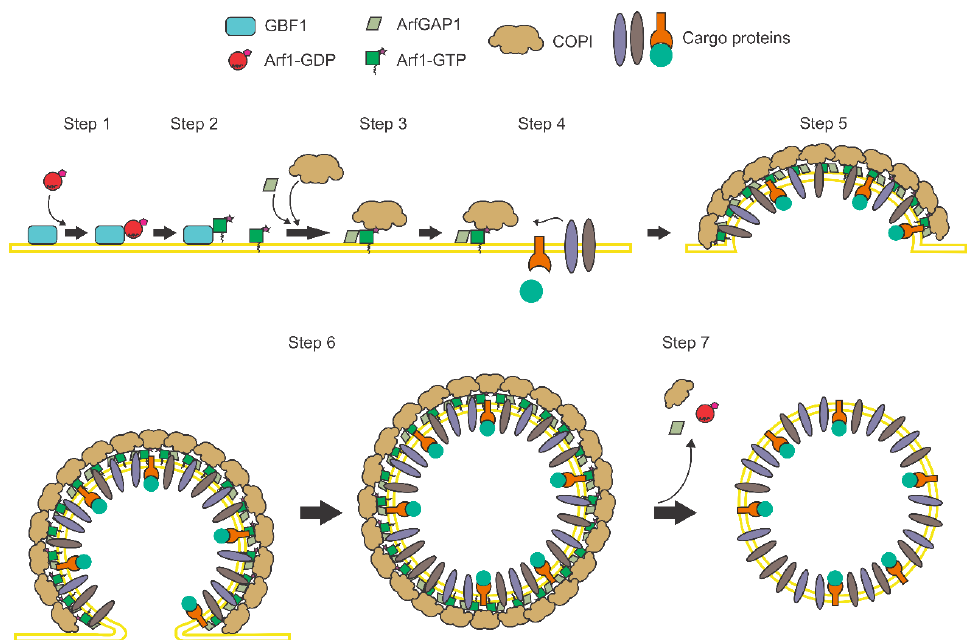
Figure 2. Mechanism of COPI transport. COPI vesicle formation starts when the small GTPase Arf1, bound to GDP (Arf1-GDP), associates with the Golgi-specific Brefeldin A (BFA) resistance factor 1 (GBF1), a guanine nucleotide exchange factor (GEF) that catalyzes the activation of Arf1 by promoting the exchange of GDP for a GTP molecule (step 1). This exchange induces a conformational change in Arf1 that leads to the exposure of a myristoyl group that allows the association of this protein with the membrane [31] (step 2). The membrane-bound Arf1-GTP then promotes the recruitment of the preformed COPI coat formed by seven subunits, called α, β, β’, δ, ε, γ and ζ, and the Arf-GTPase-activating protein 1 (ArfGAP1) (step 3). The formation of the Arf1-GTP-COPI-ArfGAP1 complex in the membranes stimulates the binding and concentration of different cargoes (step 4) and induces the bending of the membrane into a vesicle (step 5). Once the vesicle is completed, it buds from the membrane with a coat of COPI (step 6). Finally, the coat proteins are disassembled when the GTPase activity of Arf1 is enhanced by ArfGAP1, leading to the hydrolysis of the GTP molecule, promoting the release of Arf1-GDP, the COPI subunits, and ArfGAP1 from the vesicle to produce the free carrier vesicle used in the vesicular transport (step 7) [32,33].